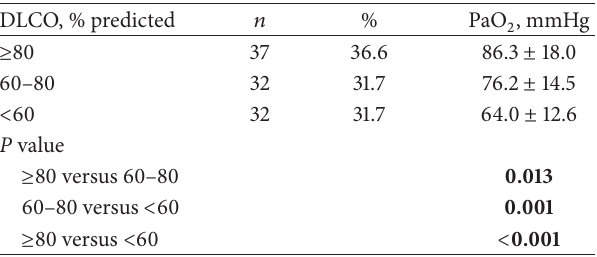
Table 3: Comparison of PaO 2 values between different groups according to HRCT